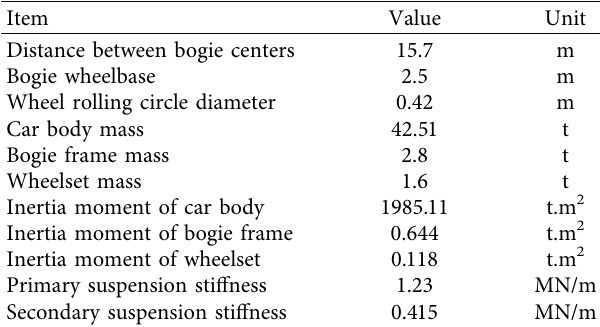
Table 1: Key dynamic parameters of the